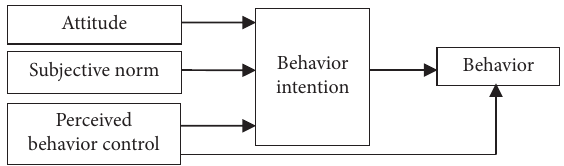
Figure 1: Model of the